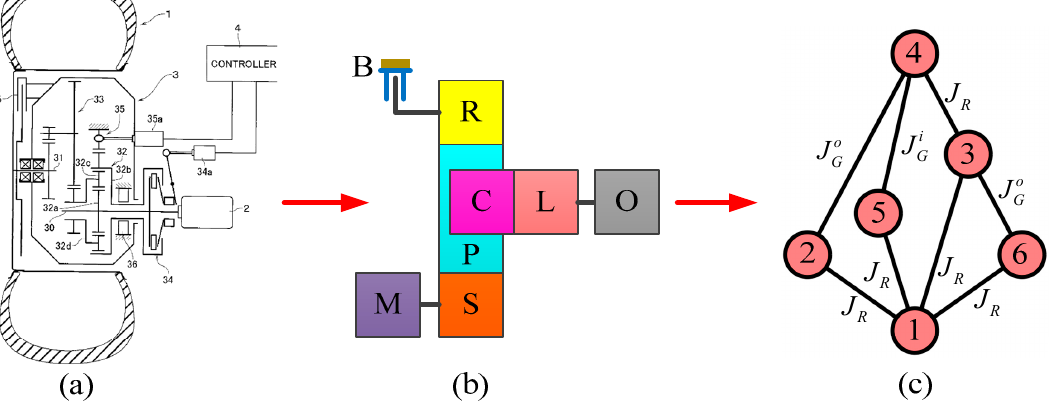
Figure 3. Motor transmission with a six-link mechanism. ( a ) schematic diagram [21]; ( b ) block diagram; ( c ) respective GKC.